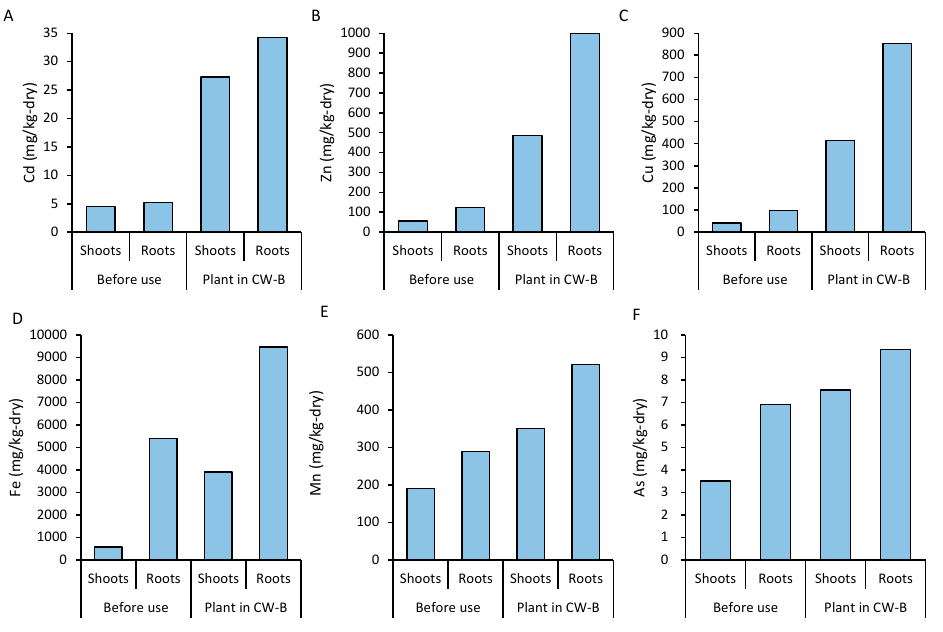
Figure 6. Metal contents in the cattail biomass in the planted CW (CW-B) before and after the NMD treatment experiment. Cd ( A ), Zn ( B ), Cu ( C ), Fe ( D ), Mn ( E ), and As ( F ). Table 2. Bioconcentration (BCF) and translation (TF) factors of cattail in the CW-B after NMD treatment.